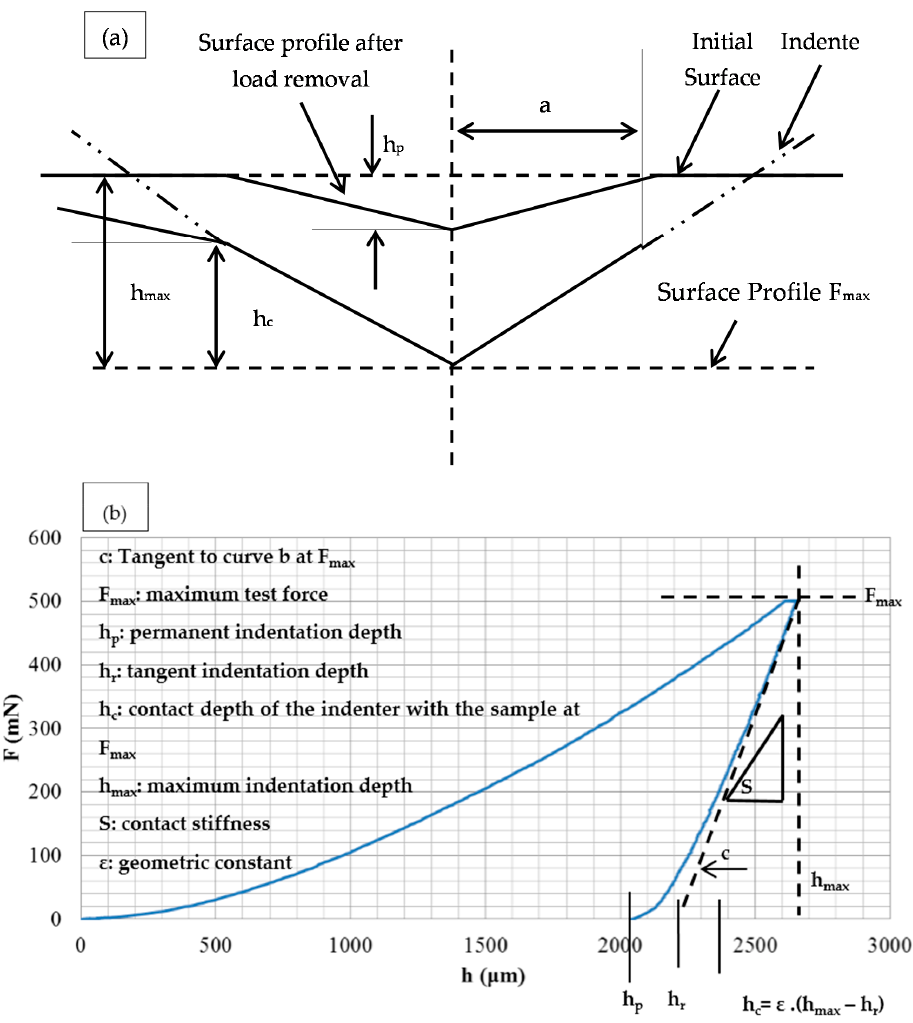
Figure 6. Microindentation images and load ‐ displacement curves of ( a ) unreinforced Fe 3 Al, ( b )